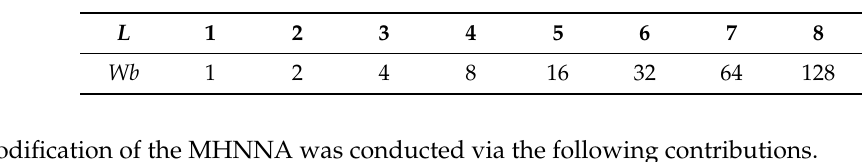
Table 4. Bitplane orders with their weights in the binary